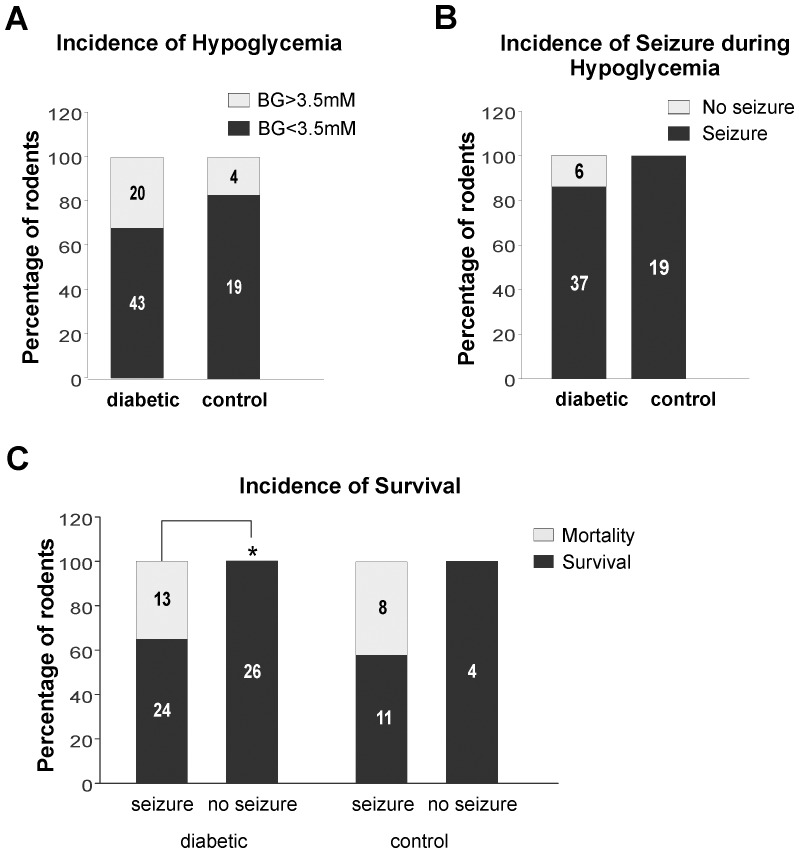
Incidence of hypoglycemia, seizures and mortality after insulin IP (15 u/kg) in overnight-fasted PN 28-30 rats; 1 week after STZ (diabetic rats) or CON (controls).
A: Incidence of hypoglycemia in all animals injected with insulin; 68% of STZ (n = 43/63) and 83% of CON (n = 19/23); no statistically significant difference between both groups B: Incidence of seizures in rodents where hypoglycemia was confirmed (BG<3.5 mM); 86% of STZ (n = 37/43) and 100% of CON (n = 19/19); no significant difference exists between the two groups C: Rate of mortality after insulin administration and hypoglycemia; 35% (n = 13/37) of STZ and 42% (n = 8/19) of CON rats. 0% mortality observed in non-seizing STZ (n = 0/26) and CON (n = 0/4) rodents. (*) Denotes a statistically significant difference in survival between seizing and non-seizing rats in the STZ group (p<0.005).